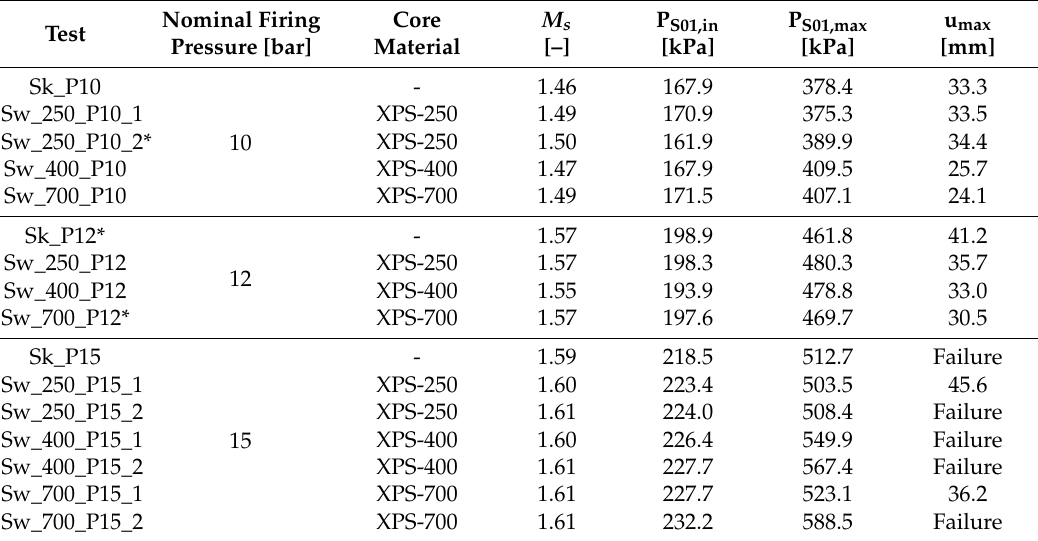
Table 3. Test matrix and selected results from blast